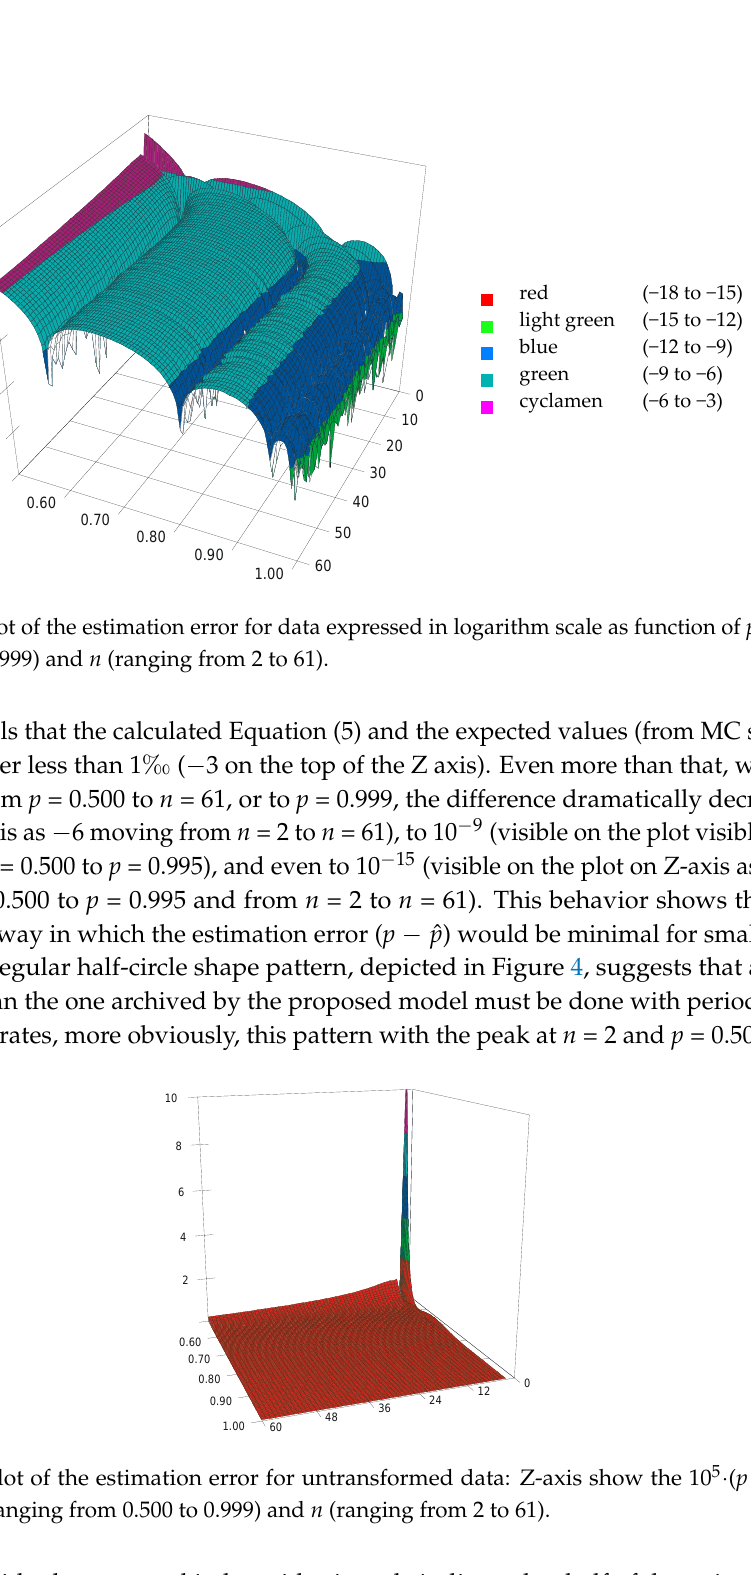
Figure 5. 3D plot of the estimation error for untransformed data: Z-axis show the 10 5 · ( p − ˆ p ) as a function of p (ranging from 0.500 to 0.999) and n (ranging from 2 to 61). Median of residuals expressed in logarithmic scale indicate that half of the points have